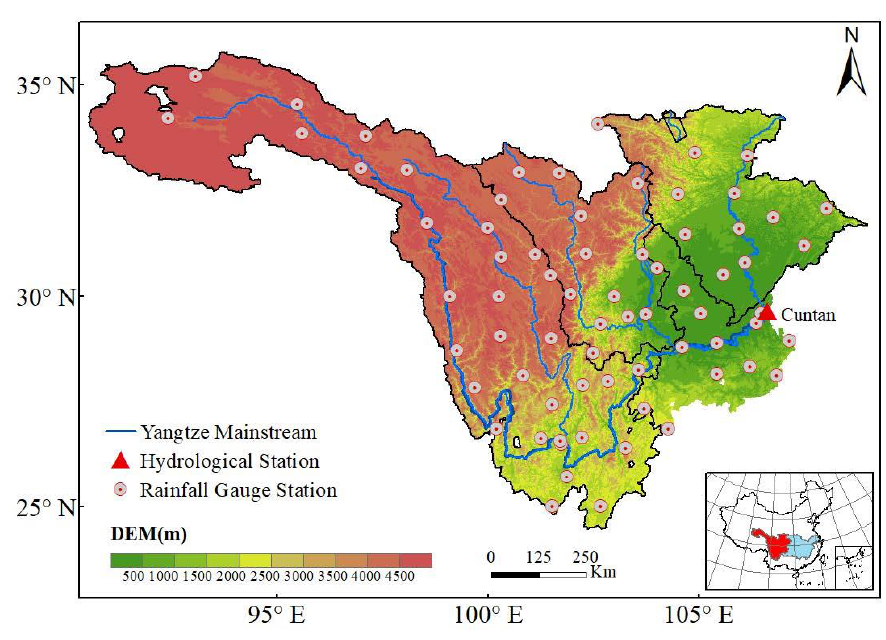
Figure 1. Location of the upper Yangtze River basin and 3 sub-basins.